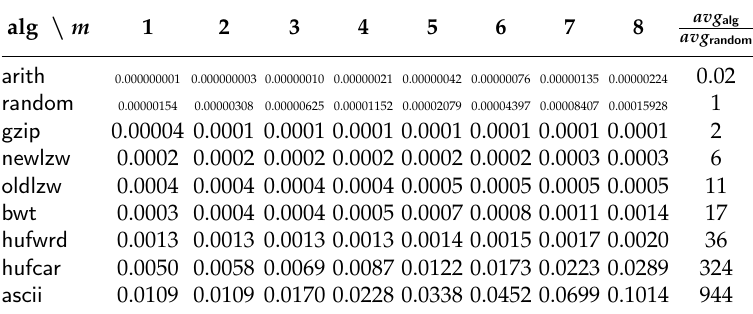
Table 2. Kullback—Leibler distance from uniform distribution.